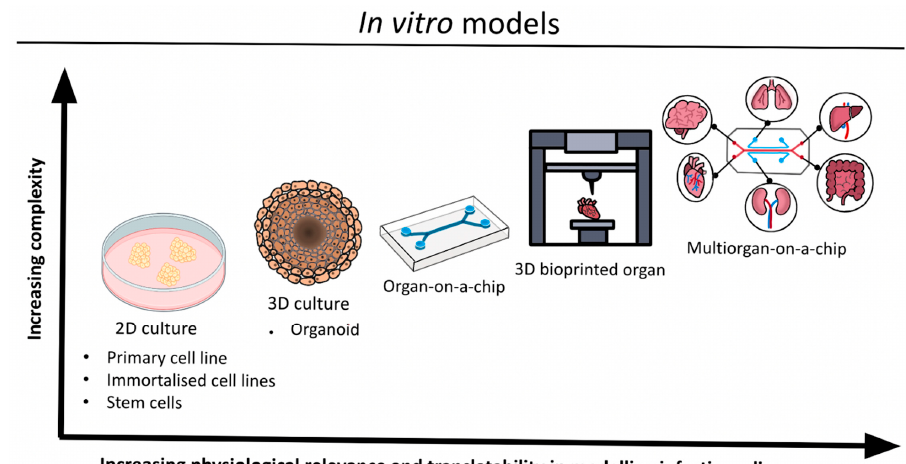
Figure 2. Schematic of in vitro platforms to model infectious diseases.